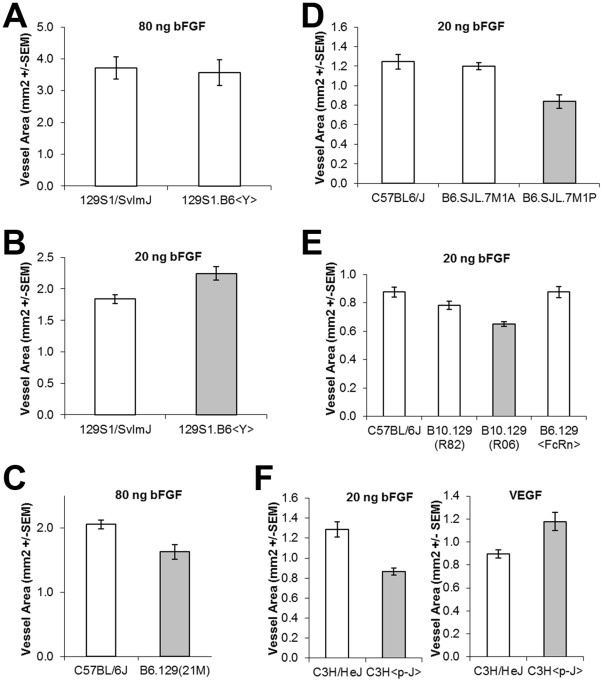
Angiogenic response of Congenic Strains.Differences between parental (leftmost) and congenic strains are statistically significant (P<0.05) except when the bar for the congenic strain is colored white.